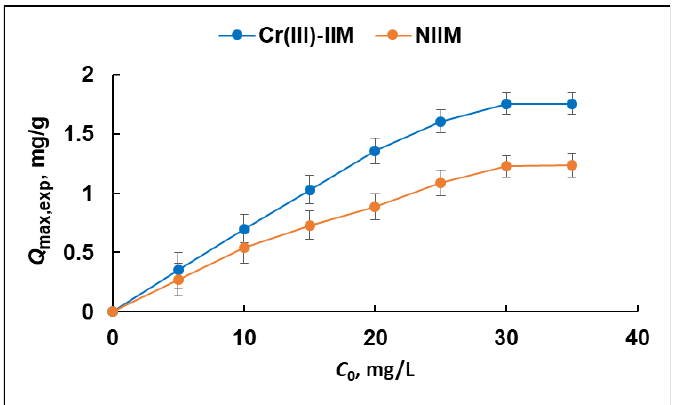
Figure 8. Effect of the initial concentration of Cr(III) on the adsorption capacity of Cr(III)-IIM and NIIM (pH 6; contact time 20 h; temperature 40 °C).